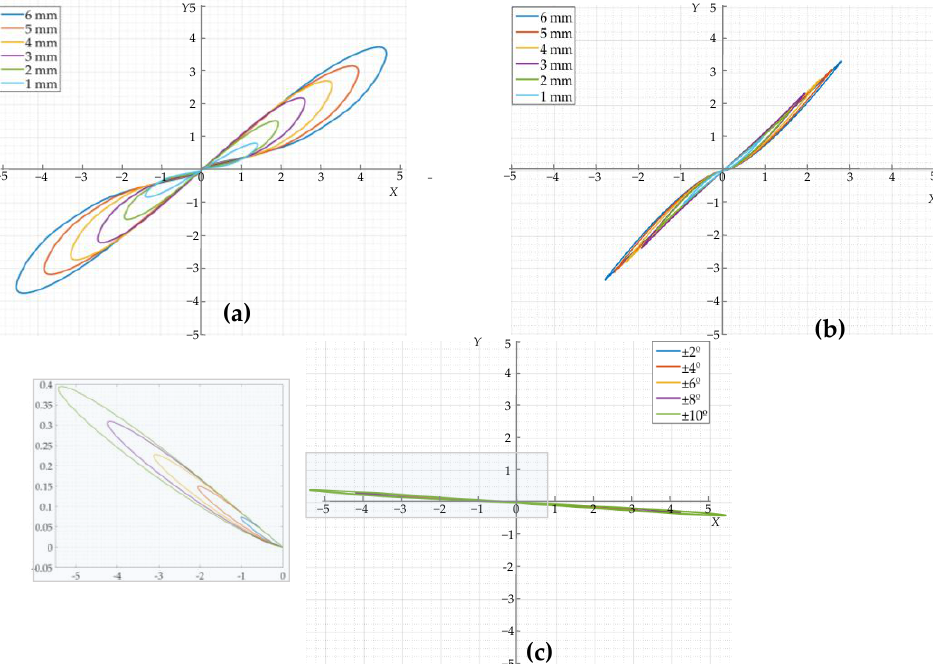
Figure 9. Amplitude-phase composite figure of the detected signals: ( a ) Amplitude-phase composite figure of the circumferential crack detection signals; ( b ) Amplitude-phase composite figure of the axial crack detection signals; ( c ) Amplitude-phase composite figure of the sensor jitter